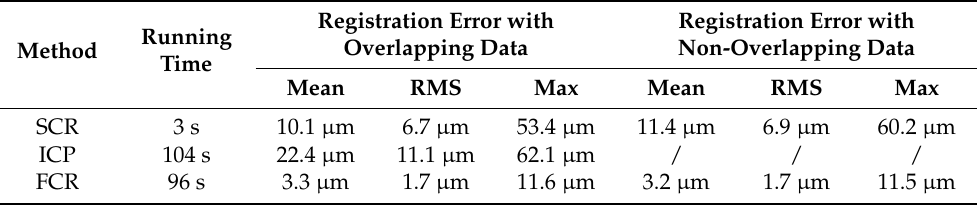
Table 1. Registration results by three registration methods with simulation